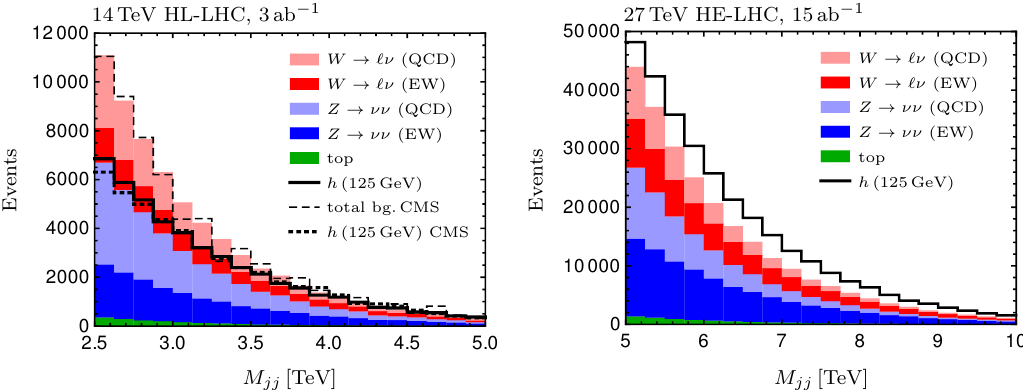
Figure 5 . Binned M jj distributions for our background (stacked histograms) and signal (thick solid line) prediction for the 14 TeV HL-LHC (left panel) and 27 TeV HE-LHC (right panel). Apart from M jj , the analysis cuts listed in table 1 are applied. For comparison, we show the total background (thin dashed line) and signal (thick dotted line) predictions for the 14 TeV HL-LHC from CMS as reported in ref.